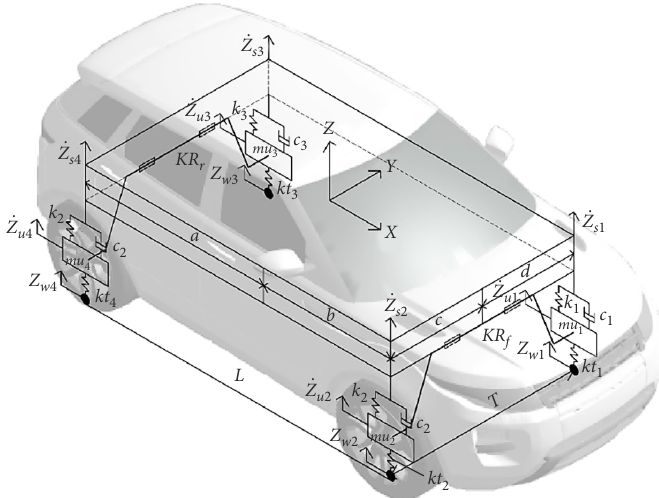
Figure 2. SUV dynamic model – modification of Šabanovič et al.